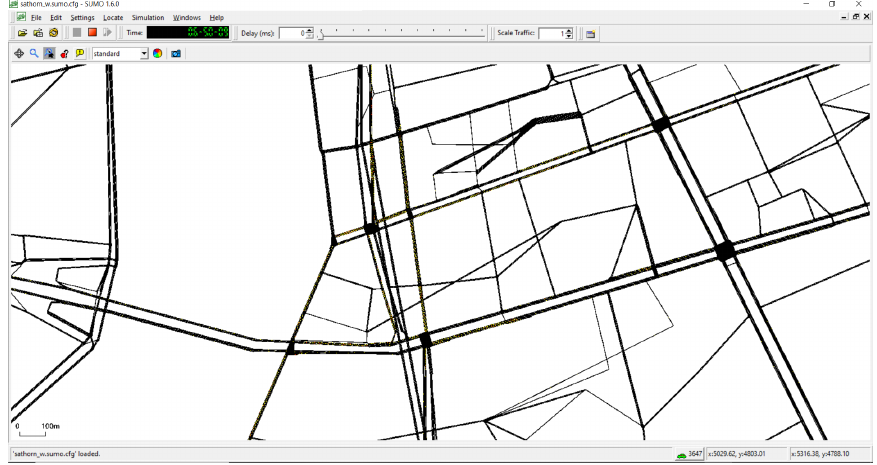
Figure 2. Sathorn road network topology in